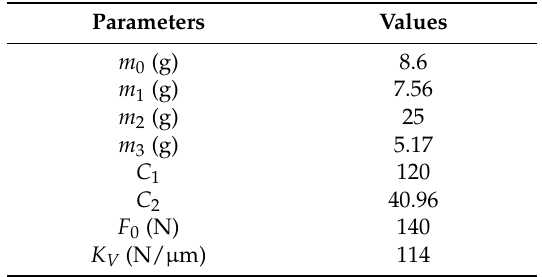
Table 3. Parameters of the dynamic model.